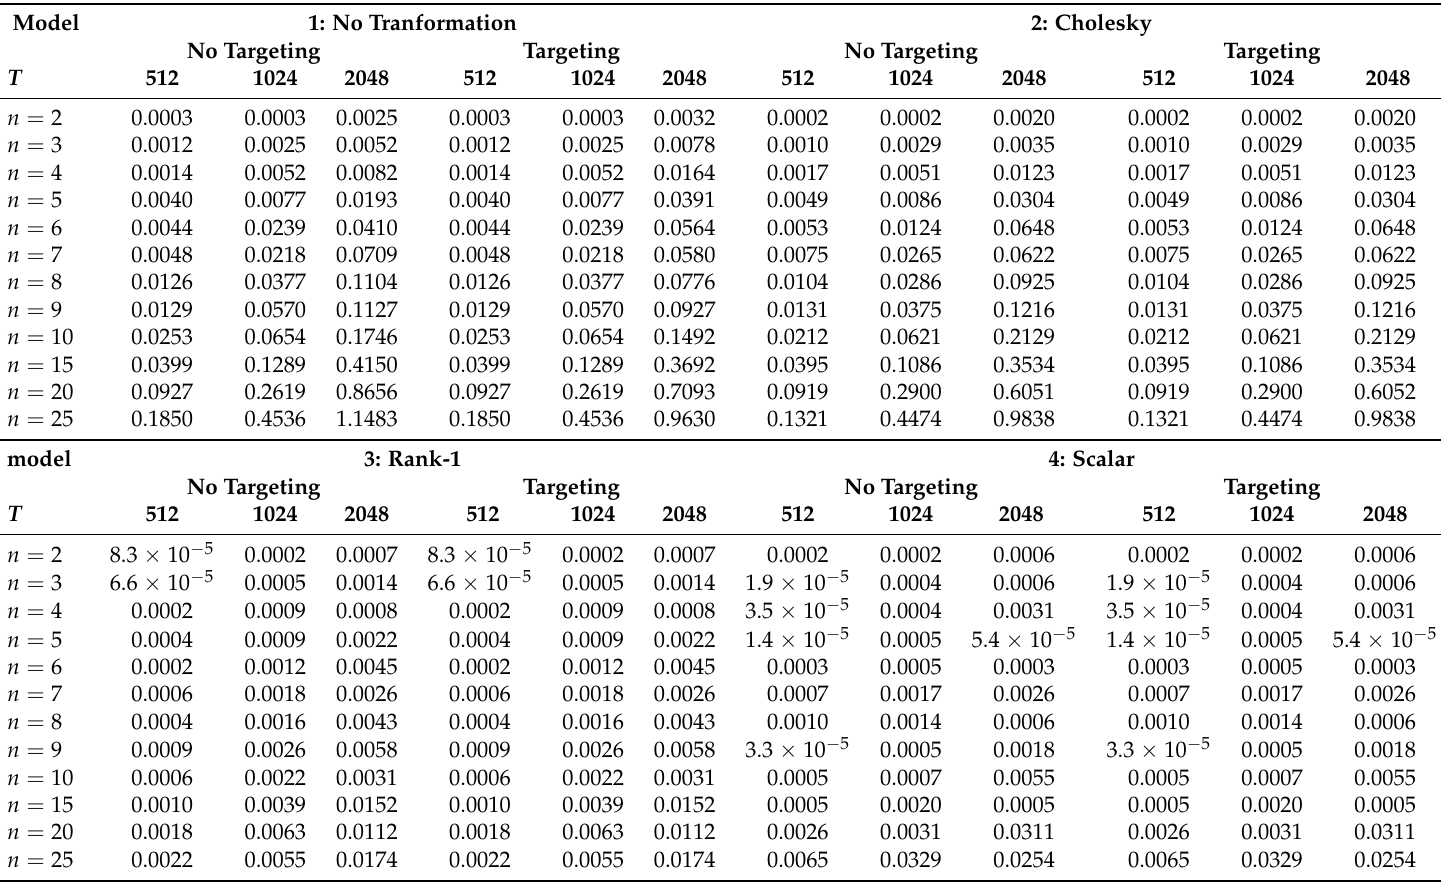
Table 1. Maximum distance indices ( d max